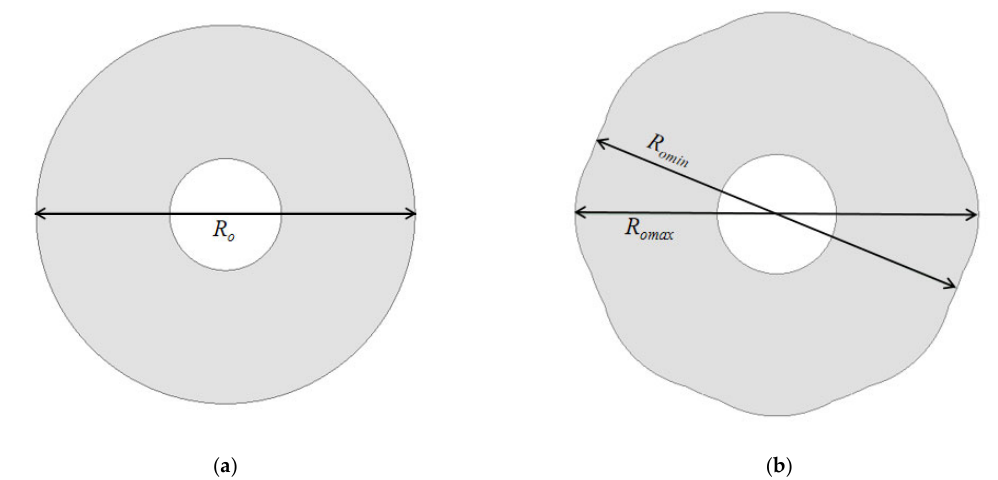
Figure 3. ( a ) Rotor structure diagram of IPMSM; ( b ) rotor structure diagram of IPMSMA.